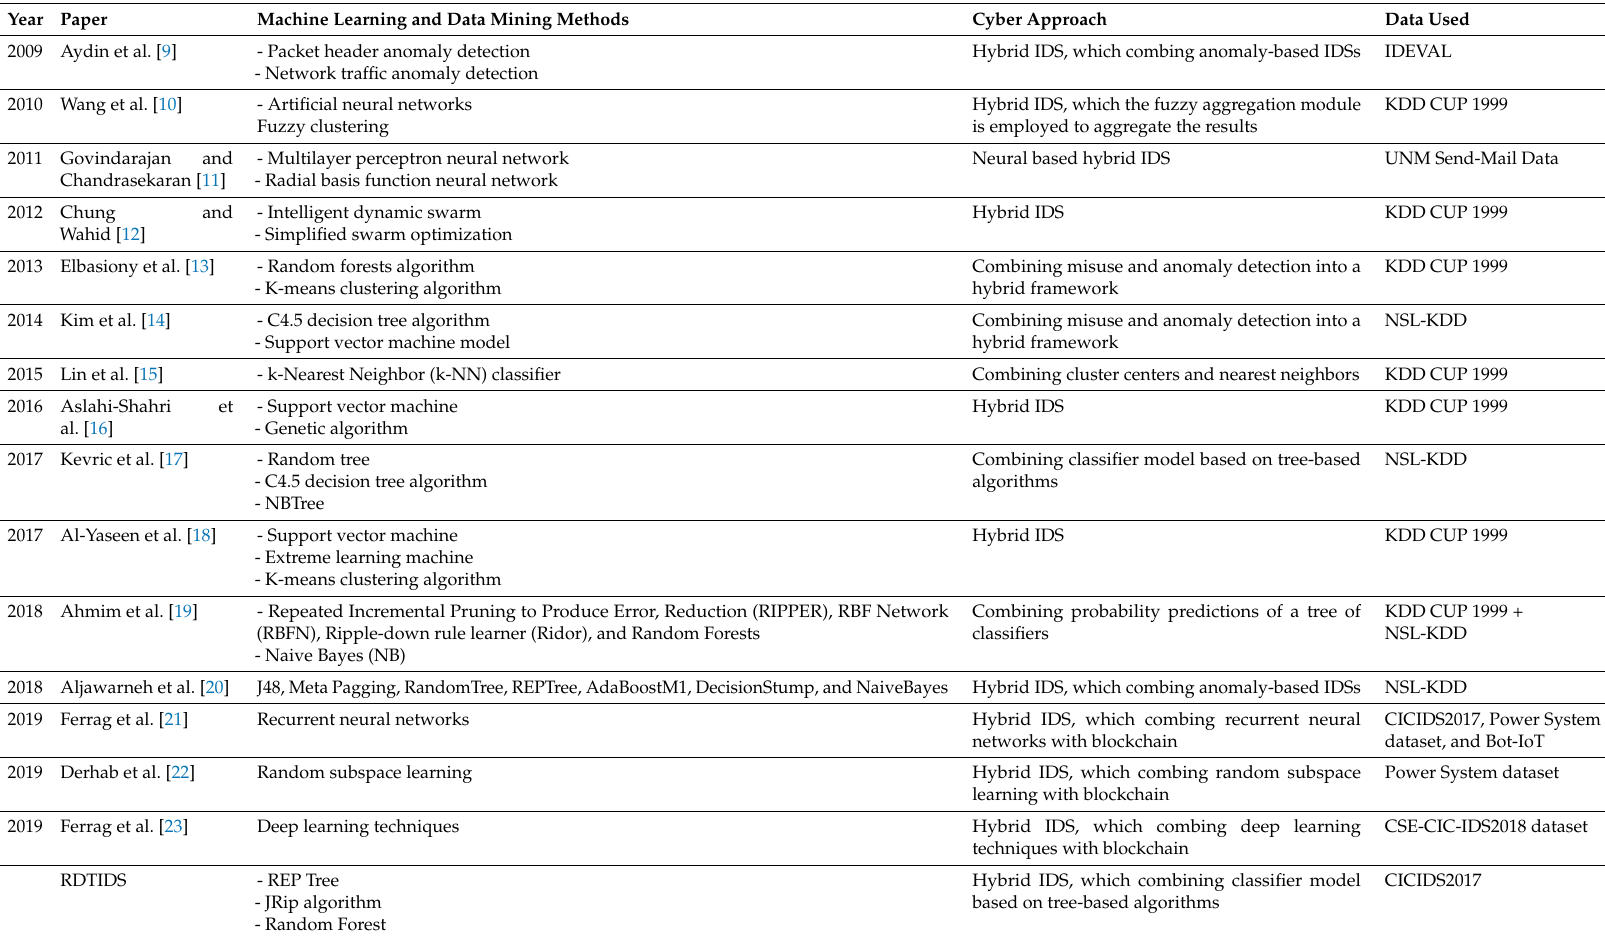
Table 1. Related works on hybrid intrusion detection